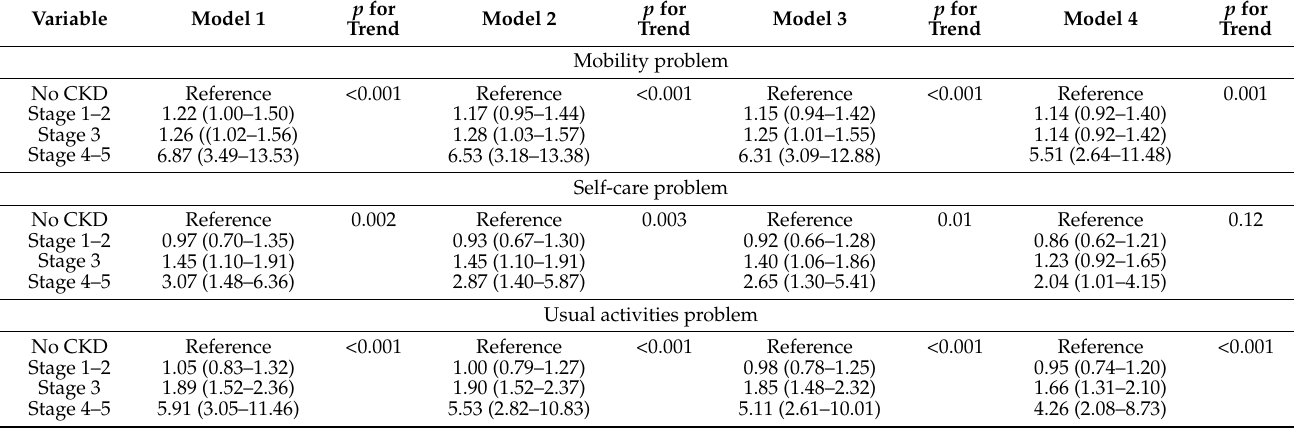
Table 3. Odds ratios of having problems in each dimension of EQ-5D by stages of chronic kidney